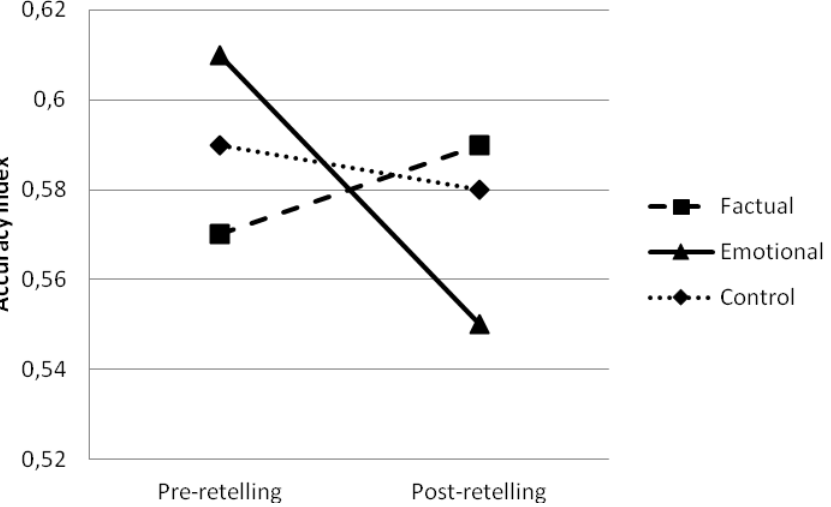
Figure 1. Interaction effect of retelling by test-retest on Accuracy